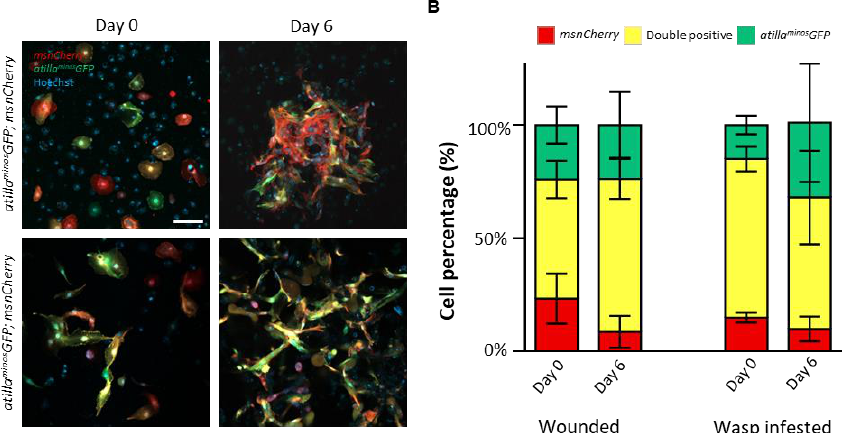
Figure 4. Lamellocyte composition in wounded and wasp-infested atilla minos GFP ; msnCherry hemo- cyte cultures. ( A ) Representative images of lamellocytes in wounded and wasp-infested atilla minos GFP ; msnCherry on Day 0 and Day 6 of culturing (green: atilla minos GFP , red: msnCherry , blue: nuclei). Scale bar: 100 µ m. ( B ) Bar graph showing the percentage of Cherry positive, GFP positive, and GFP+Cherry double positive lamellocytes in wounded and wasp infested atilla minos GFP ; msnCherry cultures on Day 0 and Day 6 of culturing. Cells in three fields of view at a 10x objective were counted from each sample (n = 3), and the data are the mean ± SD of three independent experiments. Data were analyzed using ANOVA with Tukey’s test for multiple